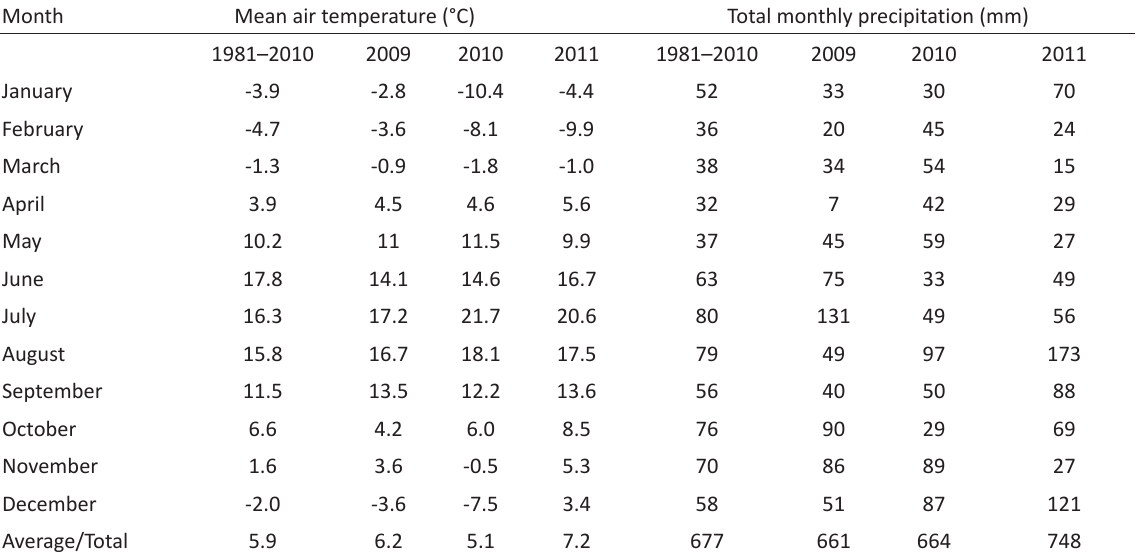
Table 1. Mean air temperature (°C) and total monthly precipitation (mm) in Helsinki from 2009 to 2011, and the long-term averages (1981–2010) (Finnish Meteorological Institute) Month Mean air temperature